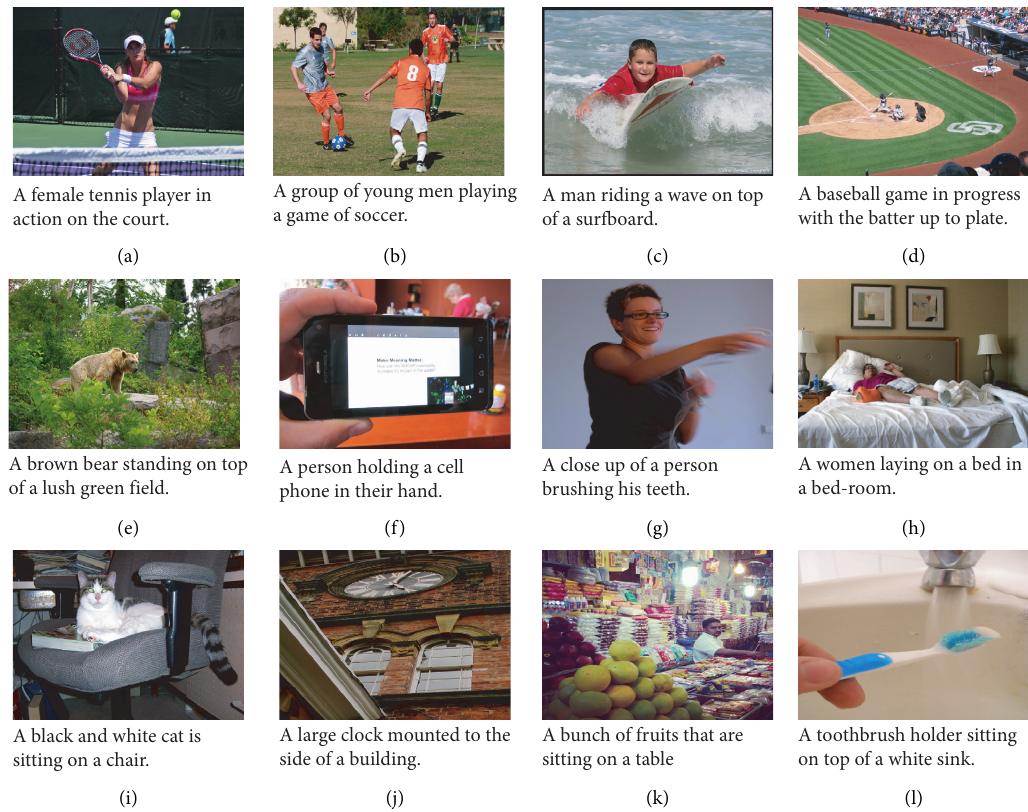
Figure 4: Sample images and their corresponding captions